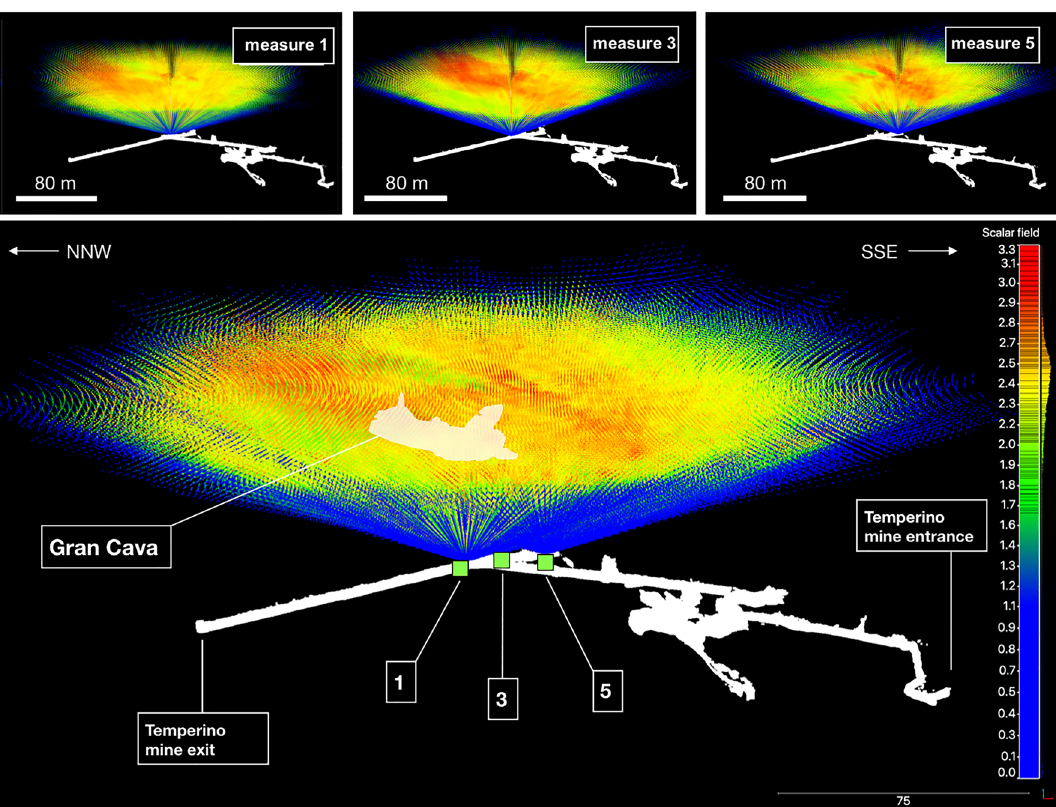
Figure 6. Operating scheme of the triangulation technique applied to the Temperino mine from the three measurement positions (1, 3 and 5) . The images were made with the CloudCompare software. The color scale follows that of the density